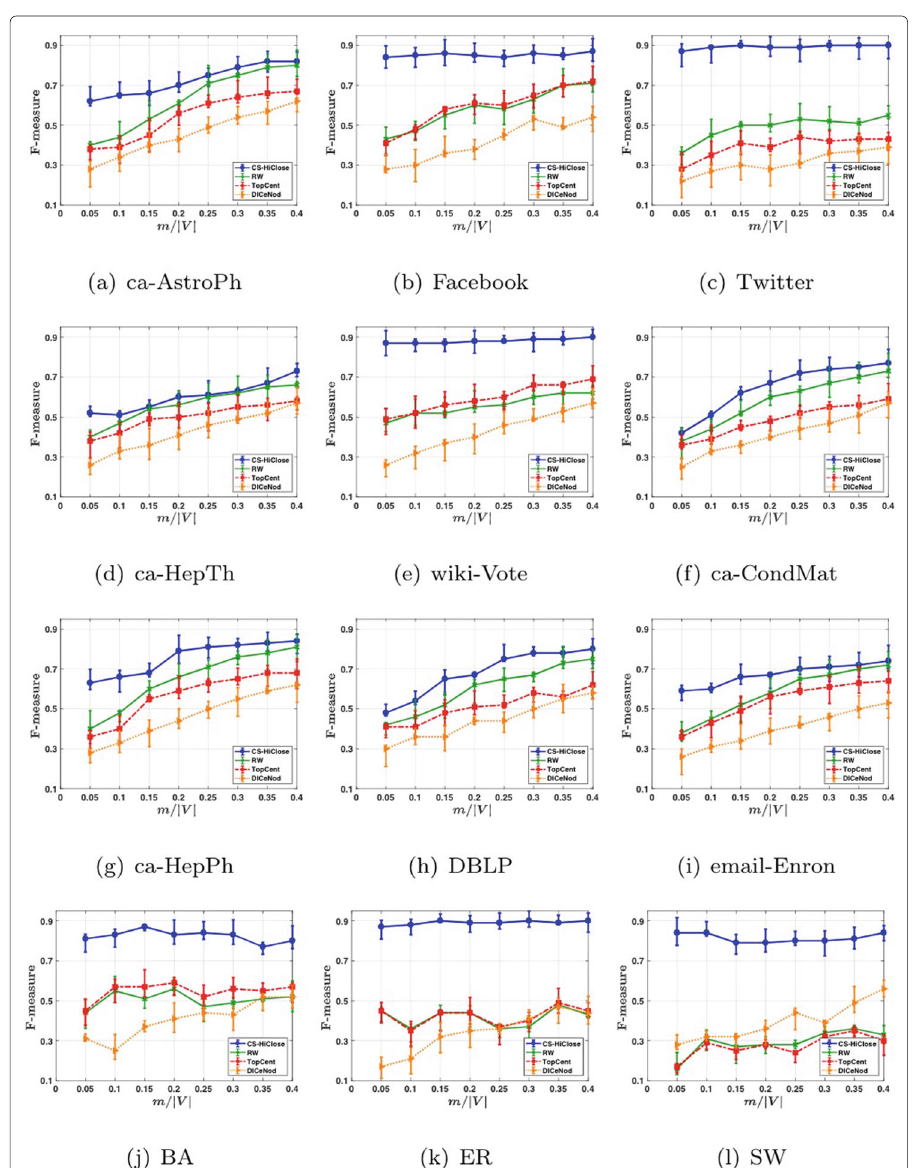
Fig. 4 Effect of the required number of measurements m on the accuracy of CS-H I C LOSE in terms of F-measure, compared to RW, TopCent, and DICeNod. For each method, we set the measurements length to 0.25 | V | and the sparsity to 0.15 | V | in a network with | V | nodes